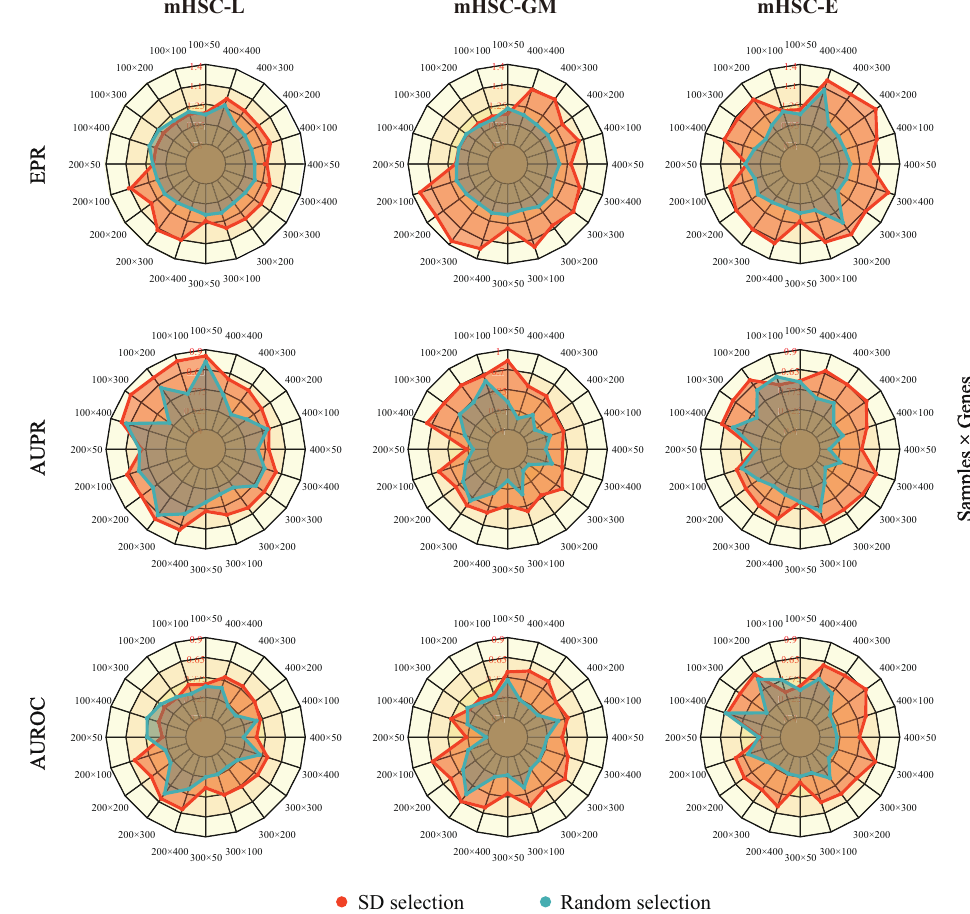
Figure 2. The robustness of our model on different data scales. Each column corresponds to a cell’s sub-dataset ( left : mHSC-L, middle : mHSC-GM, and right : mHSC-E), and each row corresponds to an evaluation index ( top : EPR, middle : AUPR, and bottom : AUROC). The red region of the figure is the result of standard deviation selection, and the blue region of the figure is the result of random selection. Pretraining and fine-tuning were not conducted for each